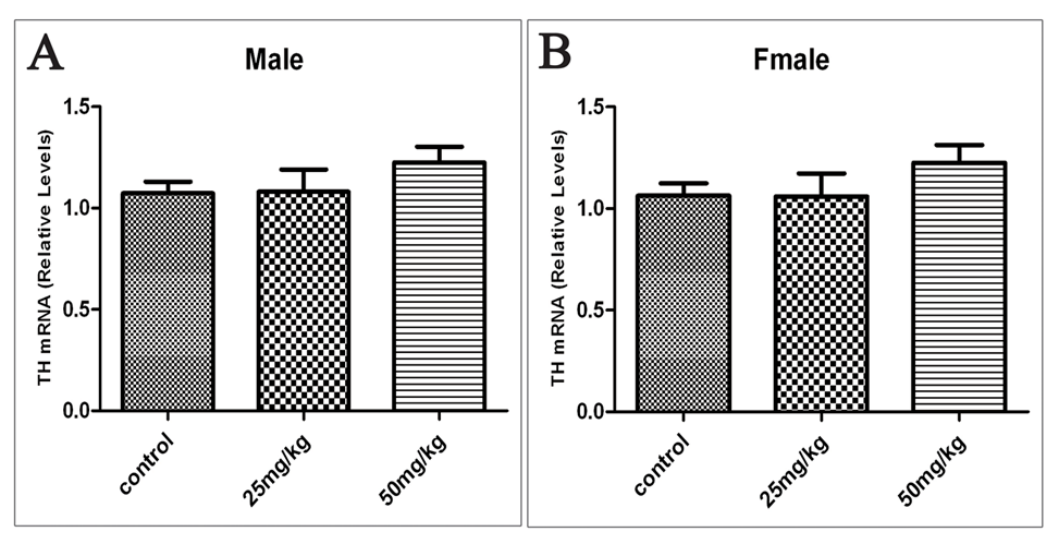
Figure 3. Offspring’s TH mRNA relative expression levels in the ventral midbrain in males ( A ) and females ( B ) exposed to ATR during gestation and lactation. ( n =